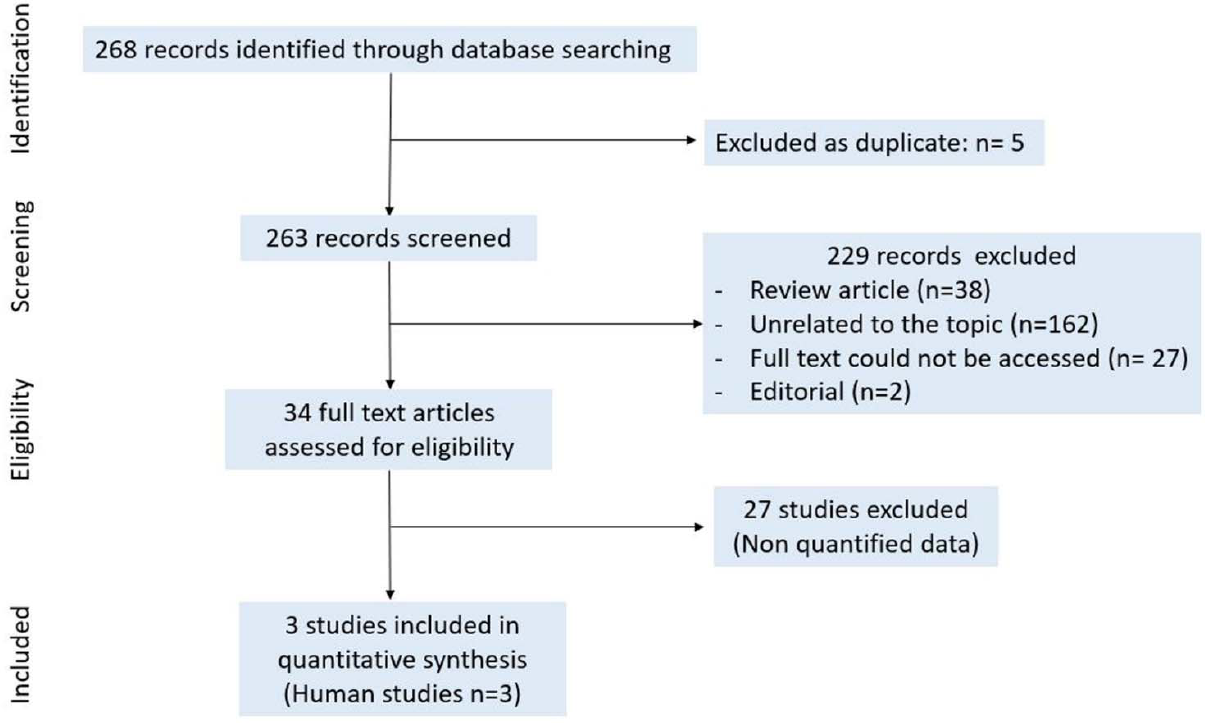
Figure 6. Study selection for DNA methylation.